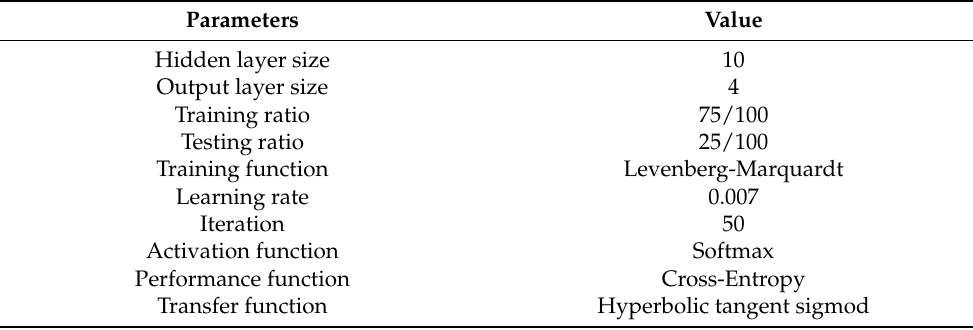
Table 4. Parameter setting of ANN.